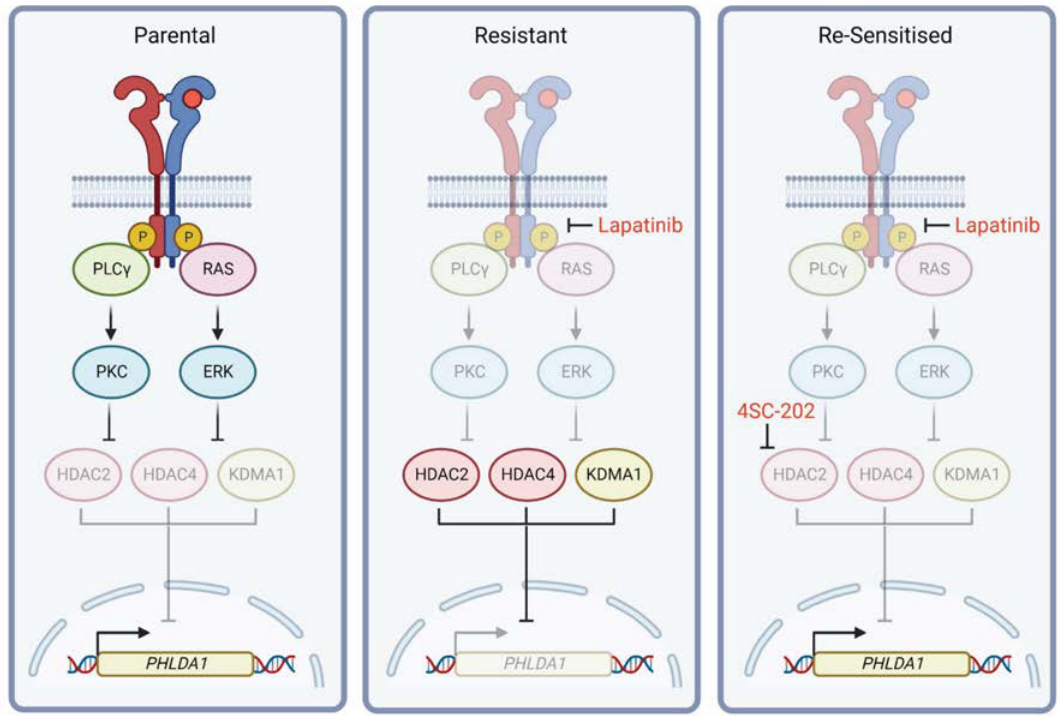
Figure 5. Proposed mechanism of PHLDA1 transcriptional regulation downstream of RTK activation. Stimulation of PLC γ and the MAPK pathway following receptor activation leads to increased activity of PKC and ERK, which in turn promotes phosphorylation and inhibition of HDAC2 (pS394), HDAC4 (pS633), and KDM1A (pS166). In resistant cells, these HDACs become active, repressing PHLDA1 transcription and allowing continued cell proliferation. Combined treatment with an HDAC inhibitor (4SC-202) recovers PHLDA1 transcription, re-sensitising cells to targeted therapy.